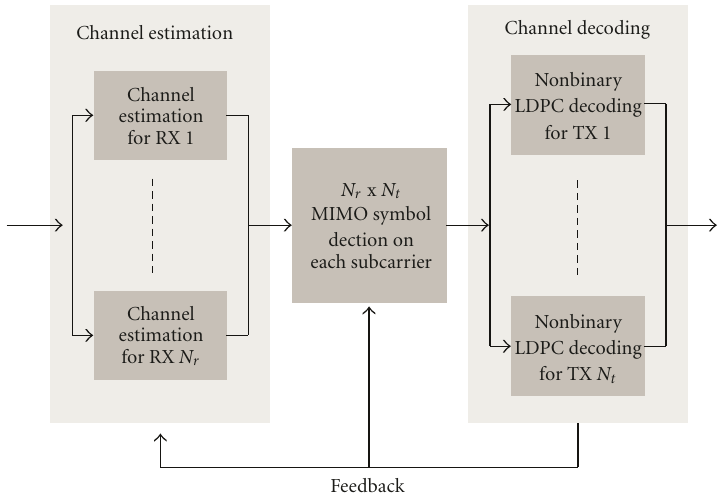
Figure 1: Iterative channel estimation and decoding for